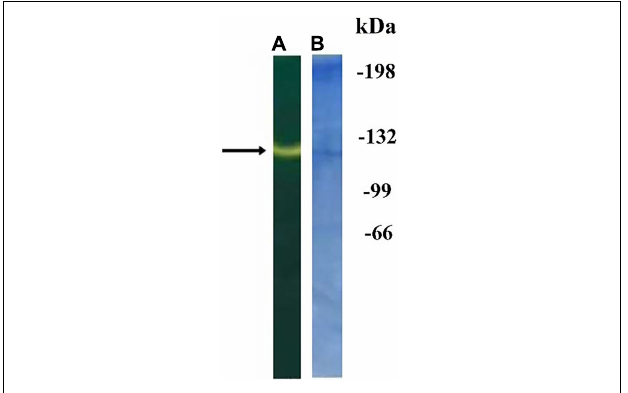
FIGURE 3 | Non-denaturing electrophoresis of proteins from thylakoid membranes (STM) obtained after affinity chromatography on agarose with mafenide: gel stained with bromothymol blue (A) ; the same gel stained with Coomassie G-250 (B) . The numbers on the right are the positions of the marker proteins with indicated molecular masses in kDa. The arrow shows the region of carbonic anhydrase (CA)